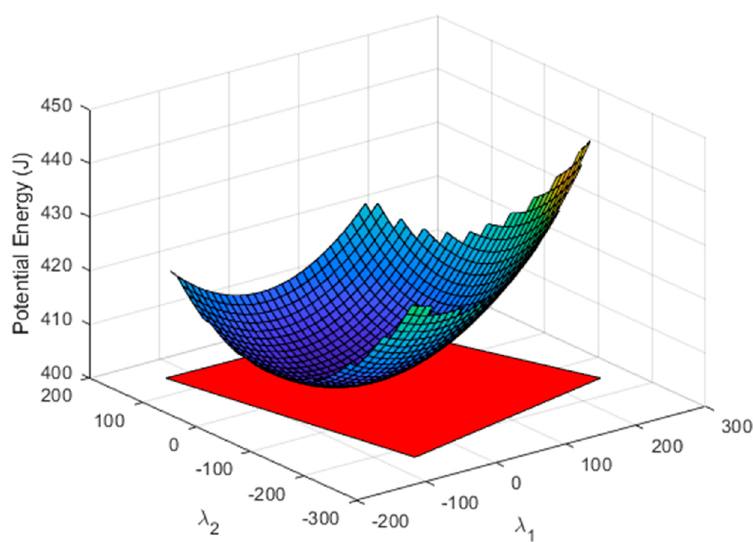
Figure 7. Surface section that represents the potential energy of all cables. The red polygon defines the region of the nullspace that provides feasible tension values in all cables.